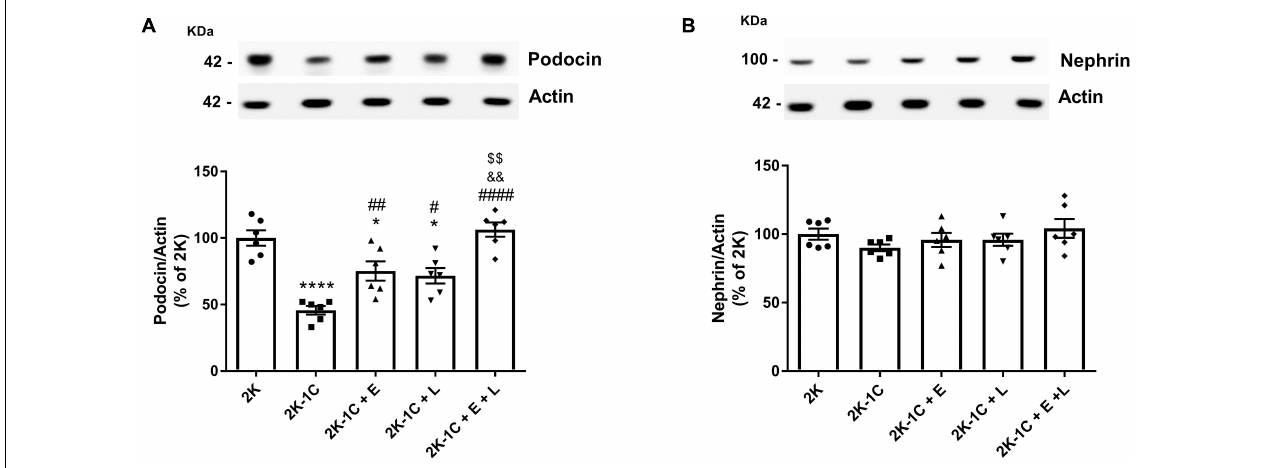
FIGURE 3 | Effect of dual versus single RAS blockade on the expression of components of the glomerular filtration barrier in the non-clipped kidney of renovascular hypertensive rats. Samples isolated from the non-clipped kidney of renovascular-hypertensive rats treated with enalapril (2K-1C + E, 20 mg/kg/day), losartan (2K-1C + L, 30 mg/kg/day), enalapril plus losartan (2K-1C + E + L, 30 and 20 mg/kg/day, respectively), or vehicle (2K-1C) and vehicle-treated control rats (2K) containing equal amounts of membrane proteins (20 µ g for podocin and nephrin and 5 µ g for actin) were subjected to SDS-PAGE, after which the proteins were transferred to a PVDF membrane and incubated with primary antibodies. Actin was used as a loading control. Representative immunoblots of electrophoresed renal membrane proteins and graphical representation of the relative expression of (A) podocin and (B) nephrin. The values represent individual measurements and the means ± SEM. * P < 0.05 and **** P < 0.0001 vs. 2K; # P < 0.05, ## P < 0.01, and #### P < 0.0001 vs. 2K-1C; && P < 0.01 vs. 2K-1C + E; $$ P < 0.01 vs. 2K-1C + L.